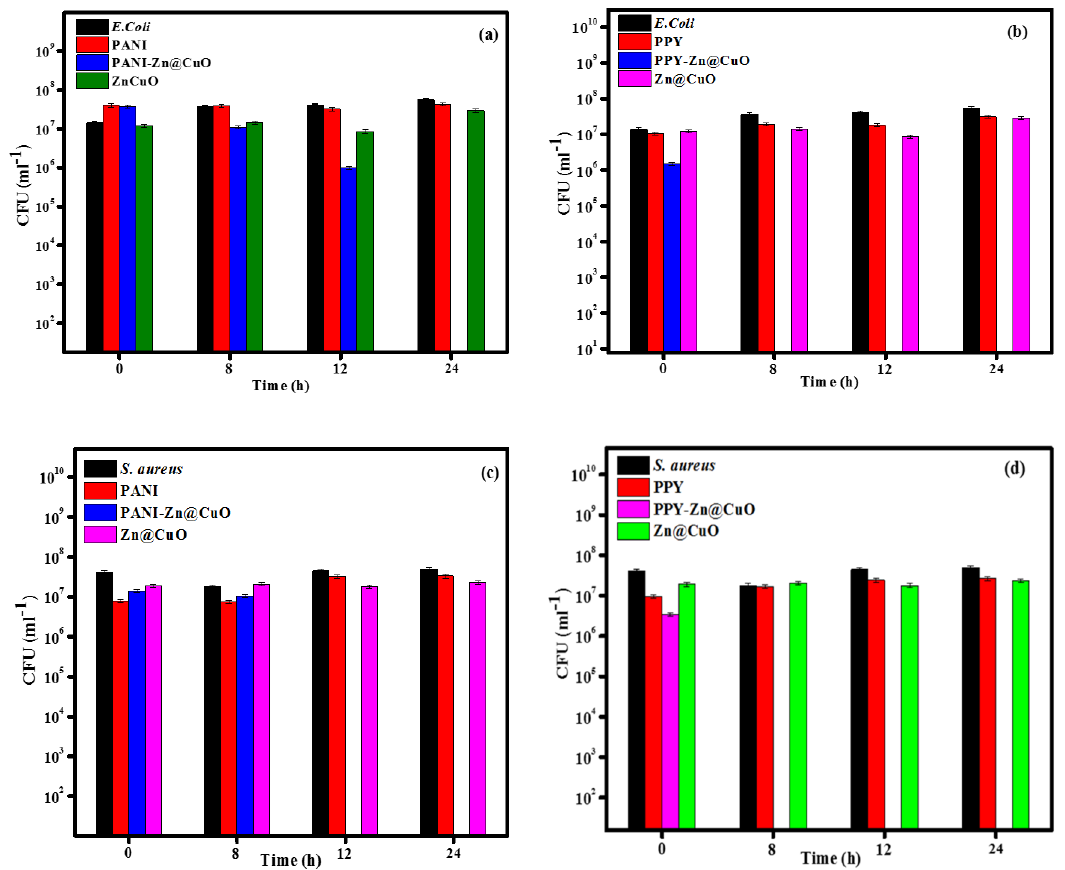
Figure 5. ( a , b ) Antimicrobial e ff ects of PANI-Zn@CuO and PPY-Zn@CuO on E. coli and ( c , d ) antimicrobial e ff ects of PANI-Zn@CuO and PPY-Zn@CuO on S. aureus . The concentration of pure PANI or PPY is 1 mg / mL, the concentration of Zn@CuO is 0.144 mg / mL, and the polymer composite consists of 0.8 mg / mL of PANI or PPY together with 0.144 mg / mL of